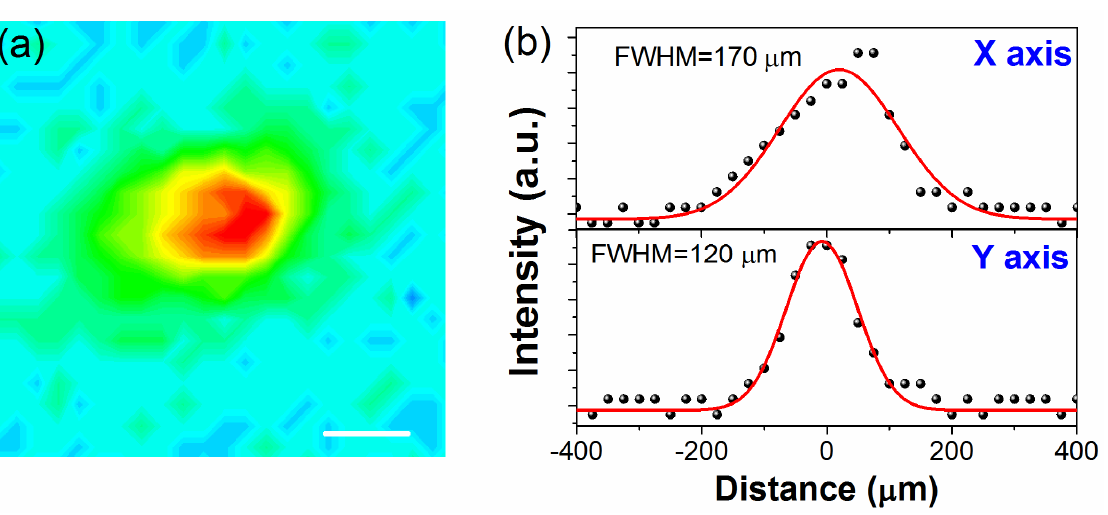
Figure 10. EUV spot size measurement ( a ) CCD image of the fluorescence of the CE:YAG crystal, irradiated with EUV beam; scale bar is 100 µm; ( b ) the measured focal spot profiles D x−FWHM ~ 170 µm and D y−FWHM ~ 120 µm.